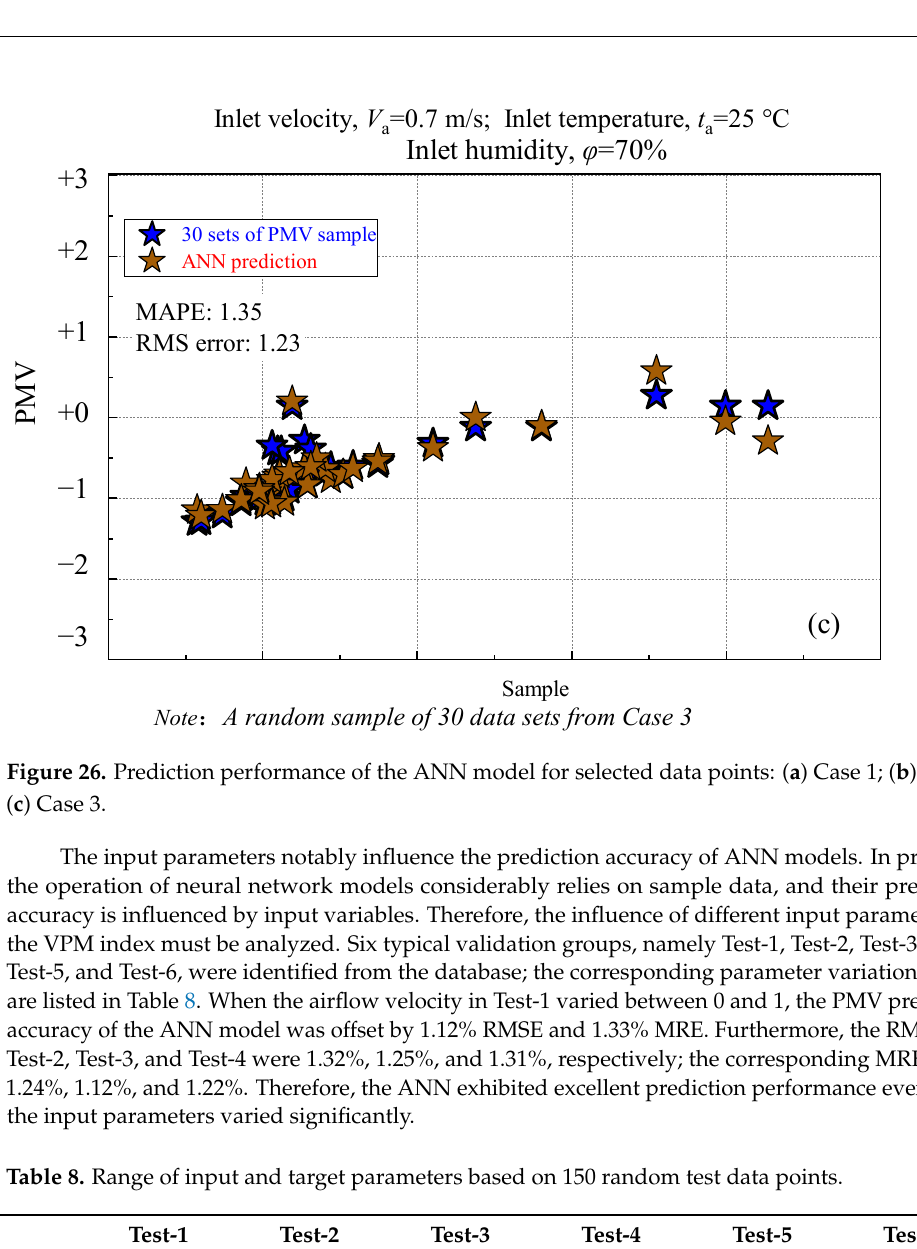
Table 8. Range of input and target parameters based on 150 random test data points. Parameters